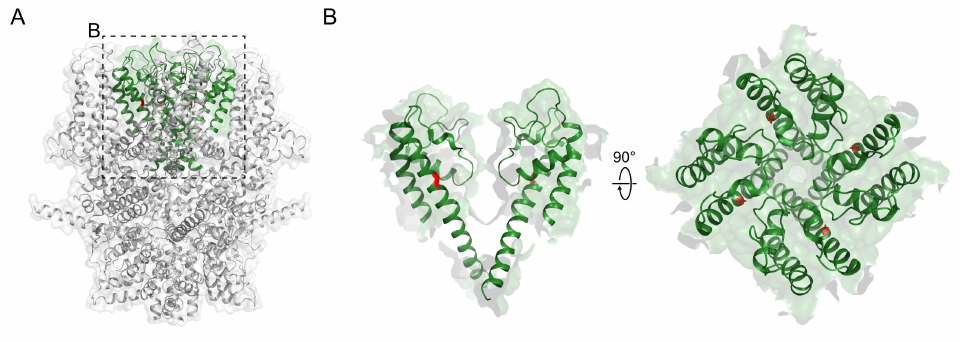
Figure 6. The homologous position of TRPC4 to G652 of TRPC3. ( A ) Glycine residue in tetrameric structure. Green domain : pore helices; Red sticks : glycine residues. ( B ) Left panel: enlarged view of pore structure and glycine. Subunits behind and in front of the paper is deliberately deleted for viewer’s preference. Right panel: top-view of pore-helices and glycine